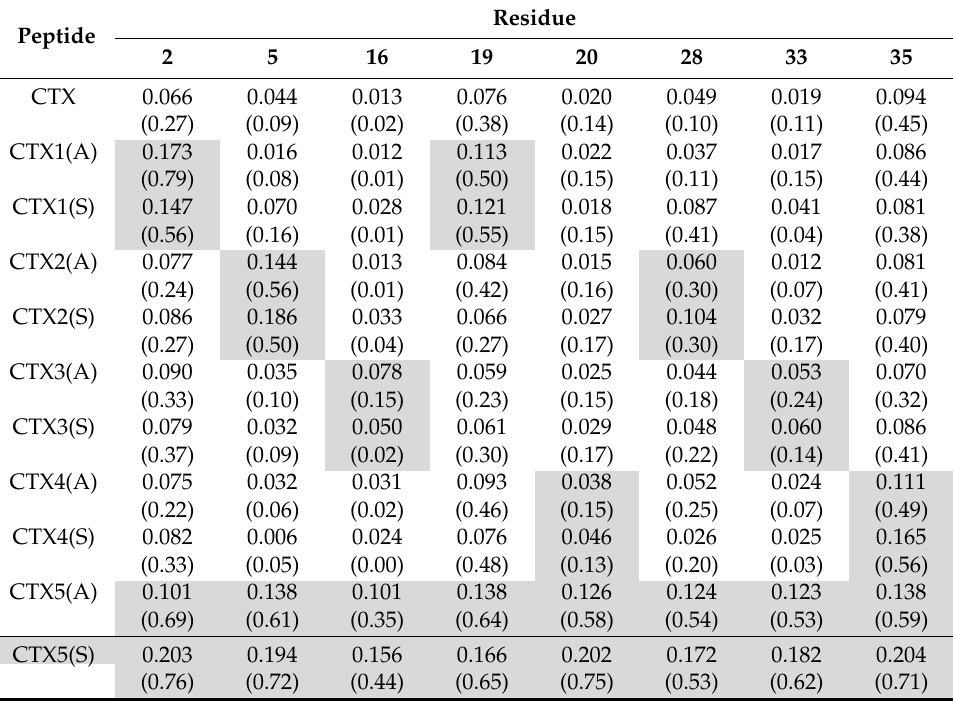
Table 4. Probability of finding water molecules within 0.5 nm of the terminal sidechain γ atoms of Cys-, Abu-, and Ser- substituted residues (S γ , C γ H γ , and O γ H γ , respectively). The relative solvent-accessible surface area (rSASA) of the residues are in parenthesis. The Abu- and Ser-substituted residues are highlighted with grey background a,b,c,d,e Residue Peptide